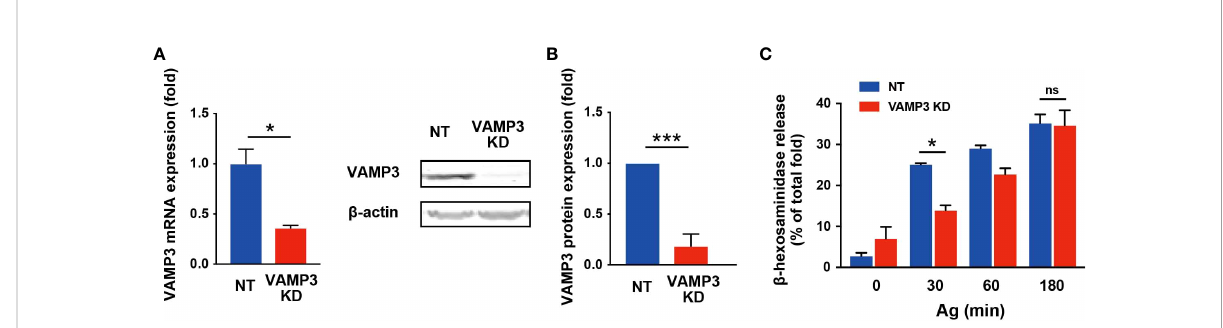
FIGURE 1 VAMP 3 knockdown attenuates b -hexosaminidase release in response to Ag VAMP3-stable KD RBL-2H3 cells were stimulated with IgE/Ag (50 ng/ml). (A) VAMP3 expression was analyzed using RT-PCR. (B) Expression of VAMP3 protein was con fi rmed using western blotting. The bar graph shows band density normalized to the loading control and compared to that of NT cells. (C) Released b -hexosaminidase was measured in the supernatant and represented as a percentage of total b -hexosaminidase in the cells. NT: control knockdown with a non-targeting shRNA plasmid. Ag: antigen. Data are presented as the mean ± standard error. n = 3 independent experiments (A – C) . *p<0.05, ***p<0.001; ns, not signi fi